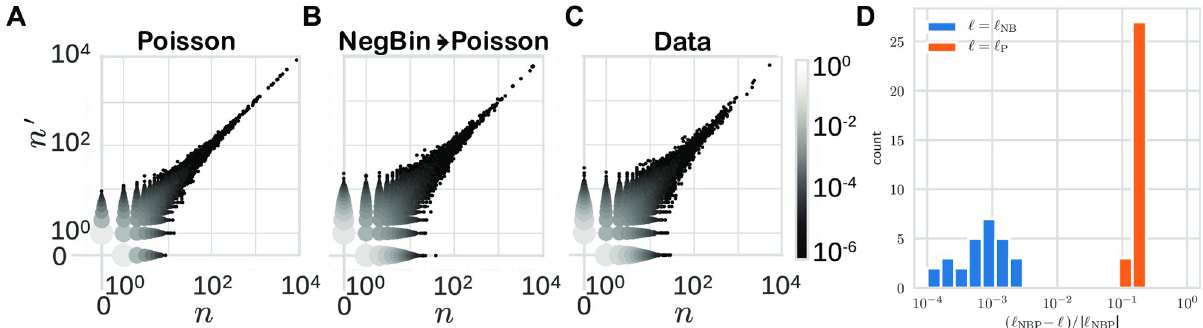
Fig 2. Comparison of measurement models. Pair count distributions sampled from learned (A) negative binomial and (B) Poisson models, compared to (C) data. (D) shows the log likelihoods, ℓ (logarithm of the argument of the argmax in Eq 6) of the Poisson (P) and negative binomial (NB) models relative to that of the two-step model (NBP). (Example dataset: day-0 replicate pair from donor S2).